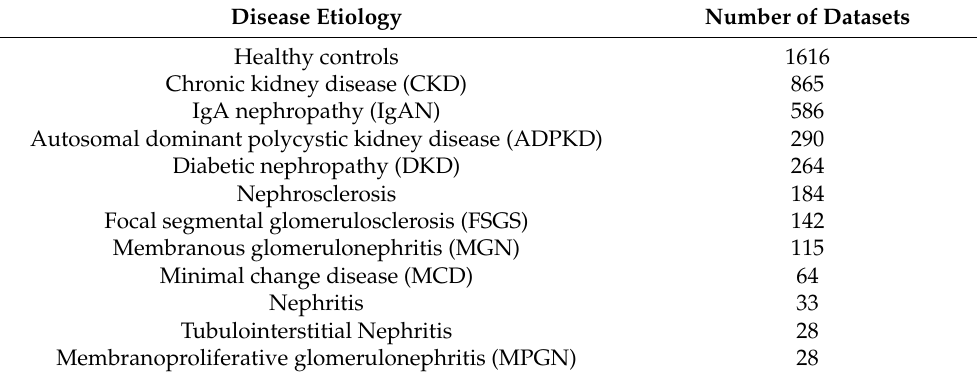
Table 4. Distribution of disease etiology, as obtained from the Human Urinary Proteome Database. (A small part, 391 subjects, were diagnosed with more than one kidney disease